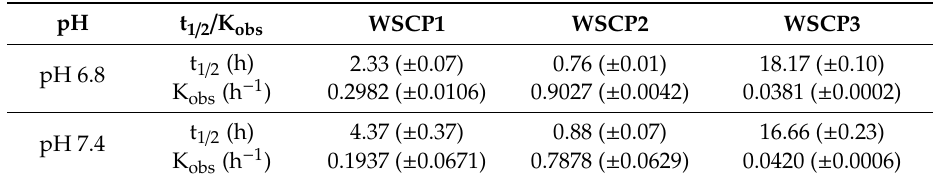
Table 1. The first-order dissociation rate constants (K obs ) and half-live times (t 1 / 2 ) of WSCP1-3 at pH 6.8 and 7.4 bu ff